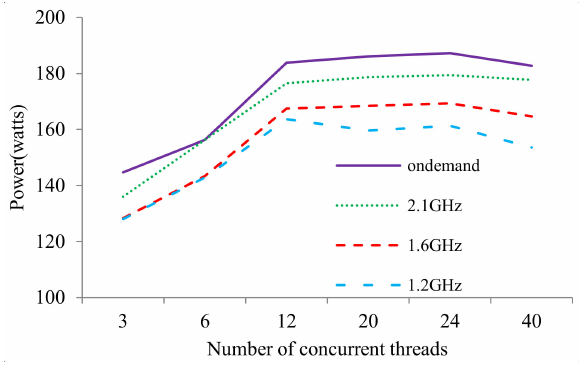
Figure 2. Power consumption of server #1 with array size = 4